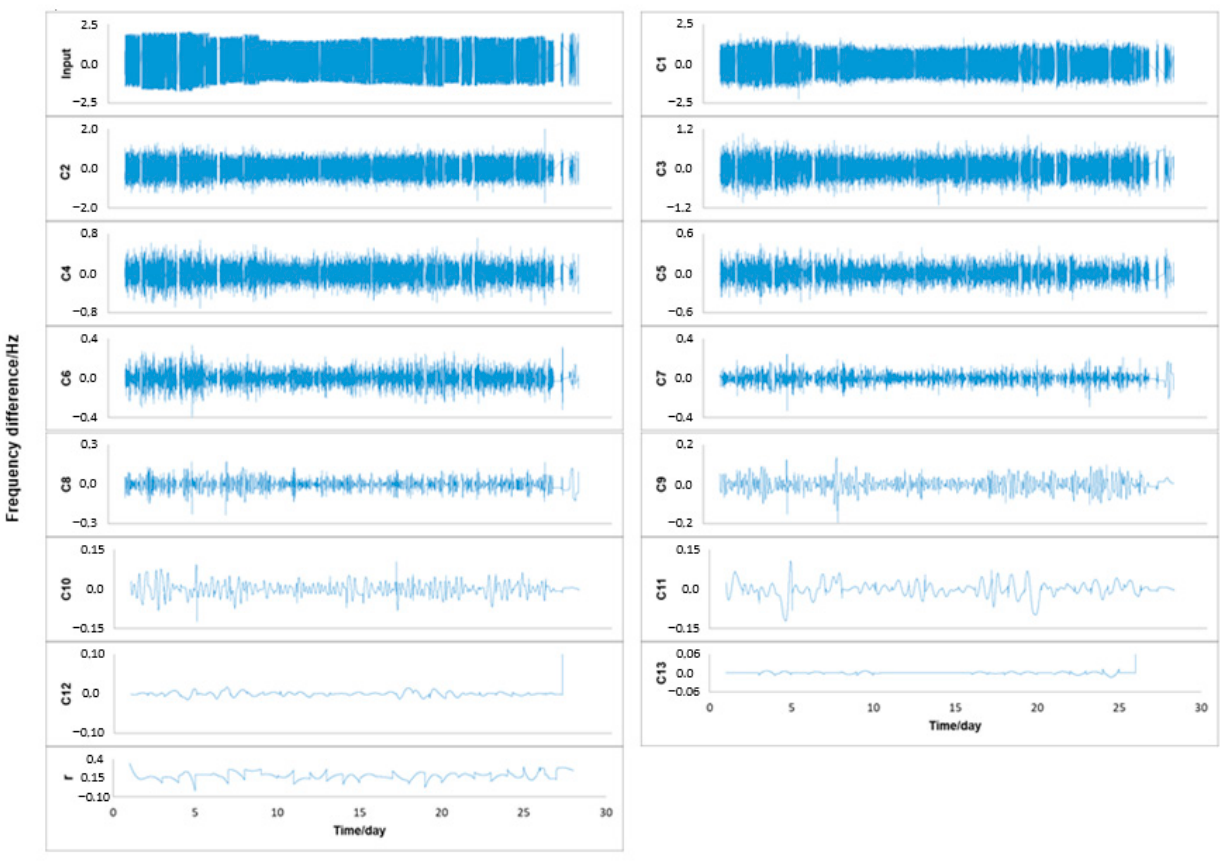
Figure 7. EEMD processing of the residual data series of the frequency difference between two optical clocks located at two sites with a height difference. The input data (the first panel ), its intrinsic mode functions ( C1 )–( C13 ), and the trend of ( r ).